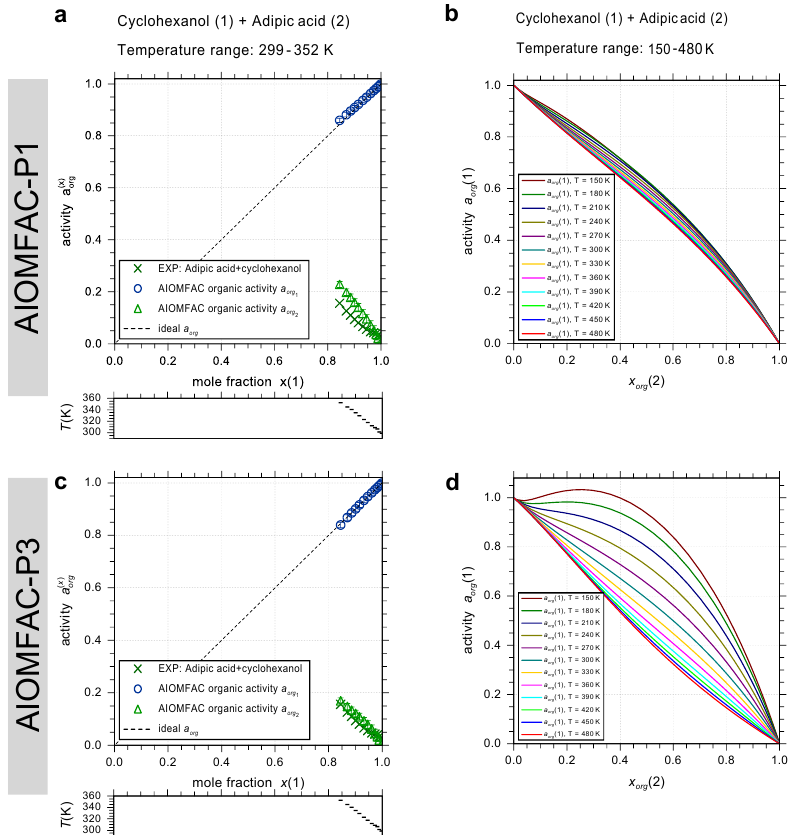
Figure 7. SLE measurements for cyclohexanol (1) + adipic acid (2) solutions and corresponding calculations of AIOMFAC-P1 (a, b) or AIOMFAC-P3 (c, d) . Panels (b, d) represent the temperature dependence predictions from AIOMFAC-P1 and AIOMFAC-P3 for the tem- perature range 150–480K. (a, c) SLE of adipic acid shown vs. mole fraction of cyclohexanol (component 1). The error bars represent the model sensitivity to a composition variation by x tol = 0 . 01. The dashed line is the ideal solution curve for component 1. The temperatures of the individual data points are given in the boxes below the main panels. Experimental data: Lihua et al.